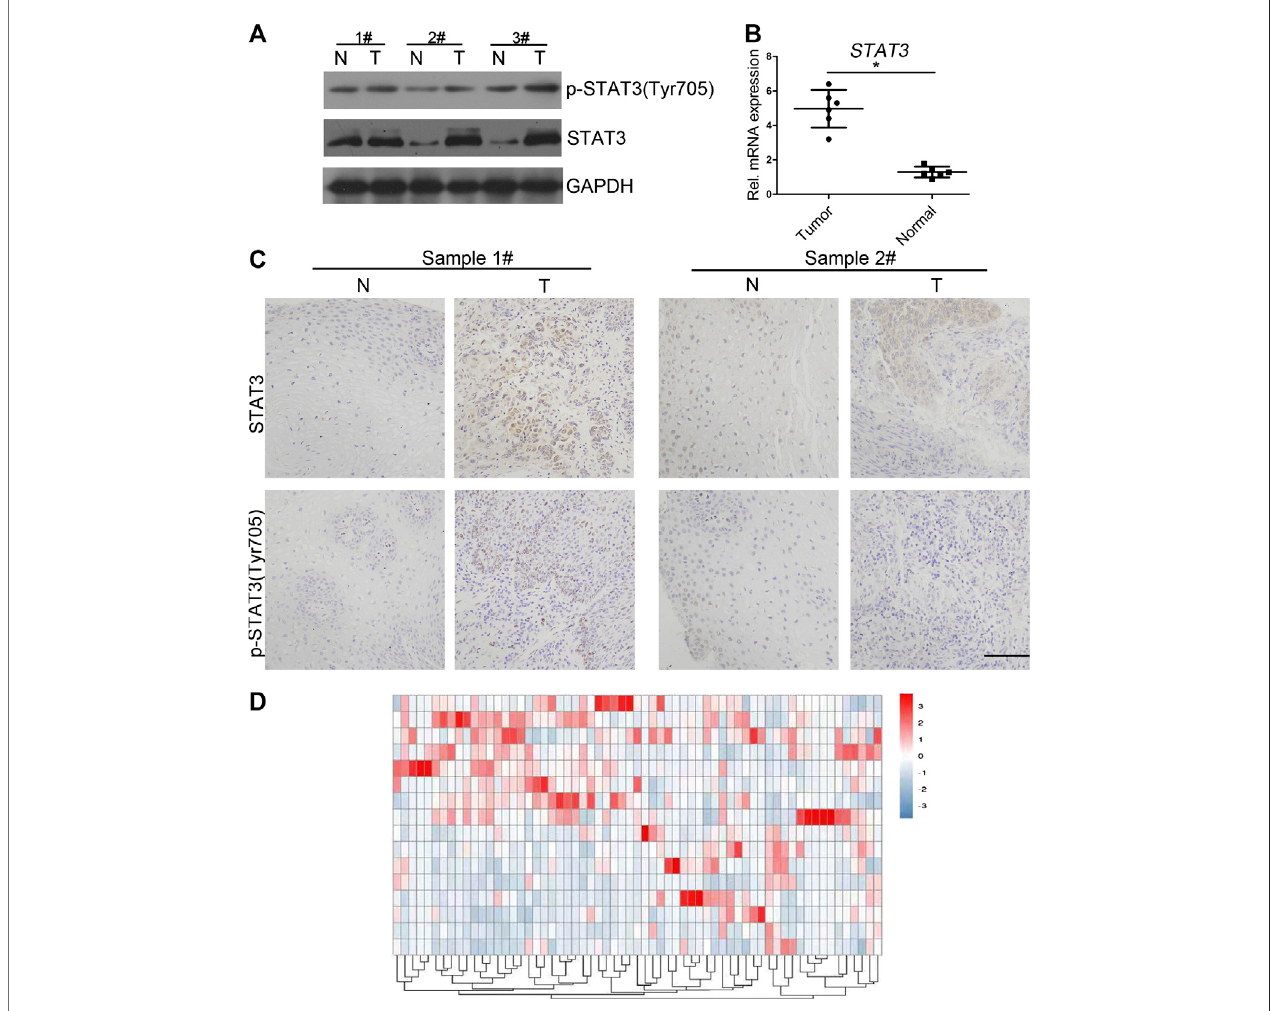
FIGURE1| ExpressionofSTAT3andp-STAT3inclinicalesophagealcancersamples (A) WesternblotanalysisoftheSTAT3expressioninclinicalsamples.STAT3 expression in tumor tissues was compared with that in the adjacent normal tissues. T, tumor tissues; N, normal. (B) qPCR analysis of the STAT3 expression level in clinical samples. mRNA expression levels of STAT3 in clinical tumor tissue were compared with that in normal tissue. The experiments were repeated three times independently (mean ± SD). (C) Expression levels of STAT3 and p-STAT3 in paraf fi n sections of clinical tumor tissue were analyzed by immunocytochemistry. Representative images ofvarious clinical esophageal cancerspecimensections from eight independent cases and thepercentage ofsamplesshowing high STAT3 and p-STAT3 expression levels are provided. Scale bar, 50 μ m. (D) Heat maps of differential expressions of mRNA in clinical esophageal cancer samples.